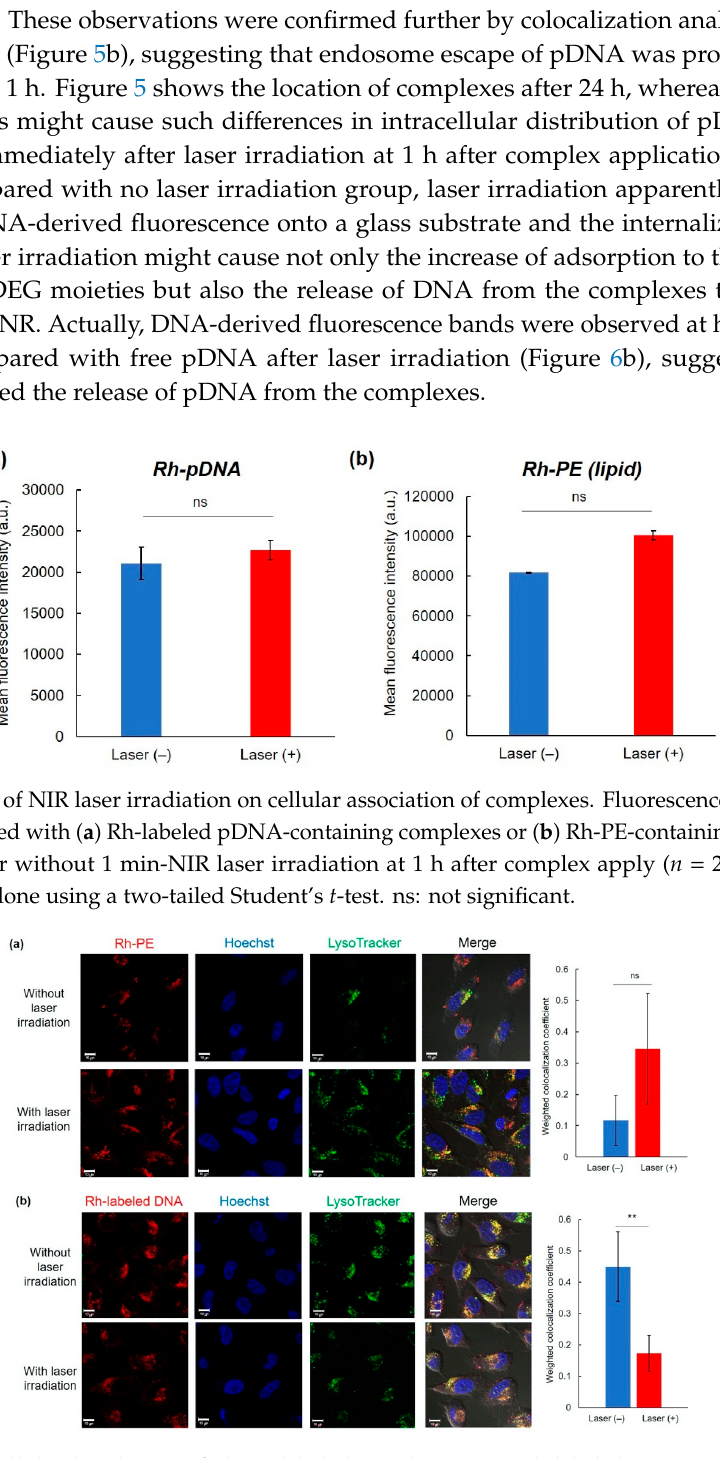
Figure 5. Intracellular distribution of Rh-PE-labeled complexes ( a ) or Rh-labeled pDNA ( b ) at 24 h with or without 1 min-laser irradiation at 1 h after sample apply. Cell nucleus and endo/lysosomes were also stained with Hoechst and LysoTracker Green, respectively. Scale bars represents 10 µ m. Weighted colocalization coe ffi cients of Rh fluorescence overlapped with LysoTracker fluorescence from each CLSM image were also shown ( n = 5–7). Statistical analyses were done using a two-tailed Student’s t -test. ** p < 0.01. ns: not